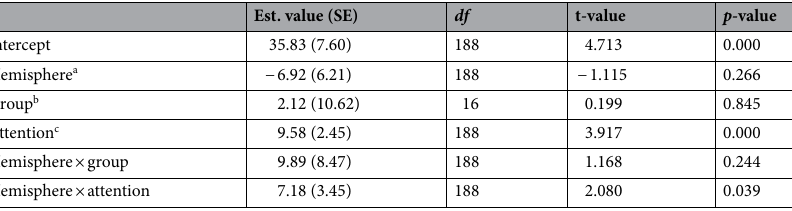
Table 1. Fixed effects of the model for the first time window: estimated difference (standard error [SE]), degrees of freedom, t-value, and p -value. a Baseline for hemisphere: right, b baseline for group: DLD, and c baseline for attention: passive.